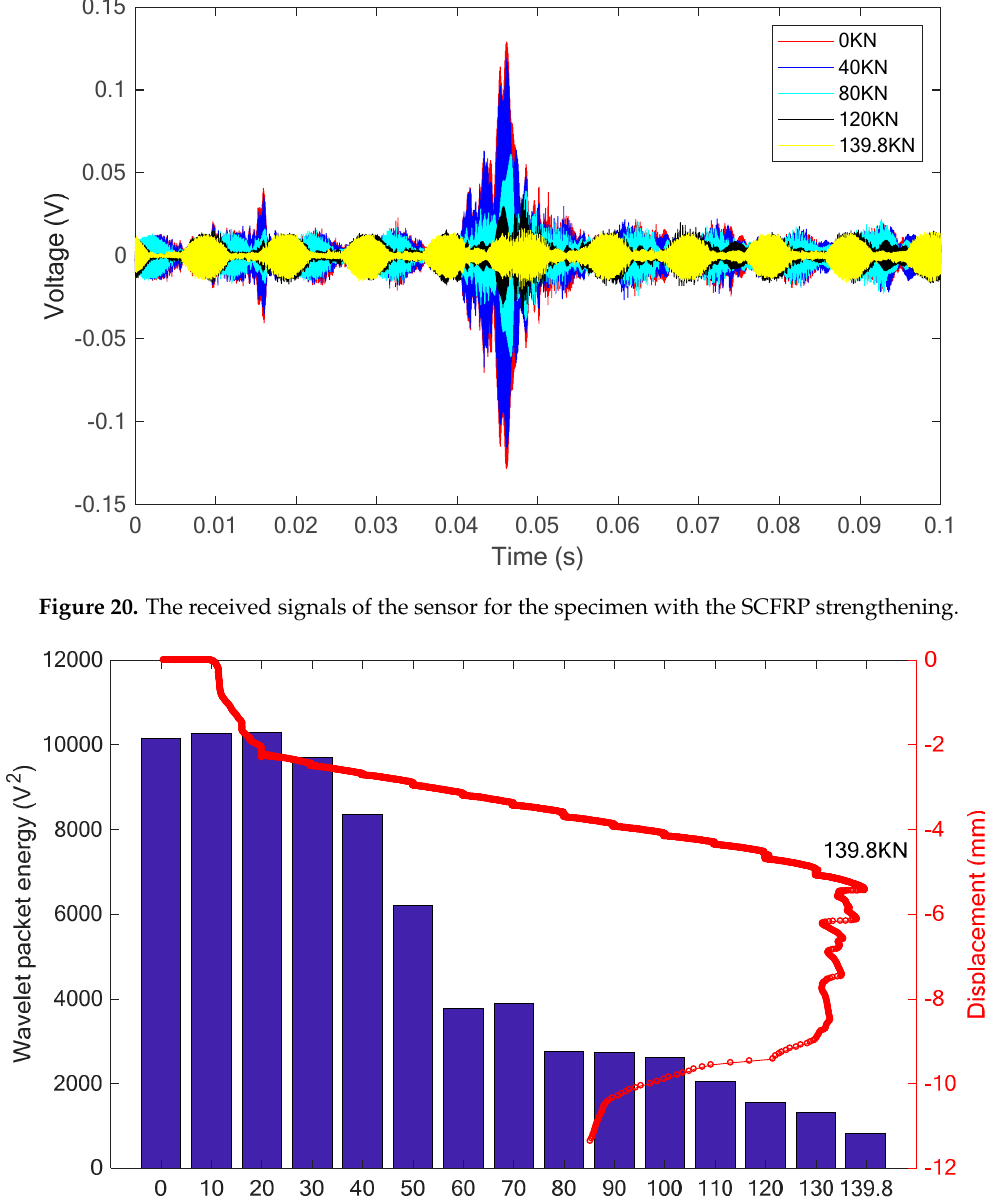
Figure 18. The curves of ( a ) time vs. load, ( b ) displacement vs. load.